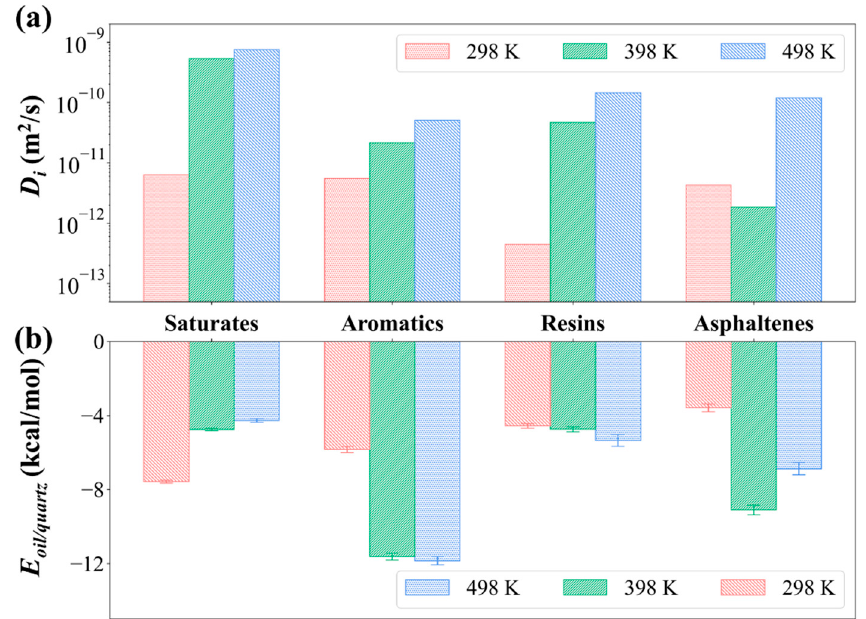
Figure 13. ( a ) The D i of SARA fractions in nanopore at 298 K, 398 K, and 498 K, respectively. ( b ) The E oil/quartz between the SARA fractions and nanopore at 298 K, 398 K, and 498 K, respectively (the minus means attraction, and the error bars are generated by time averaging).